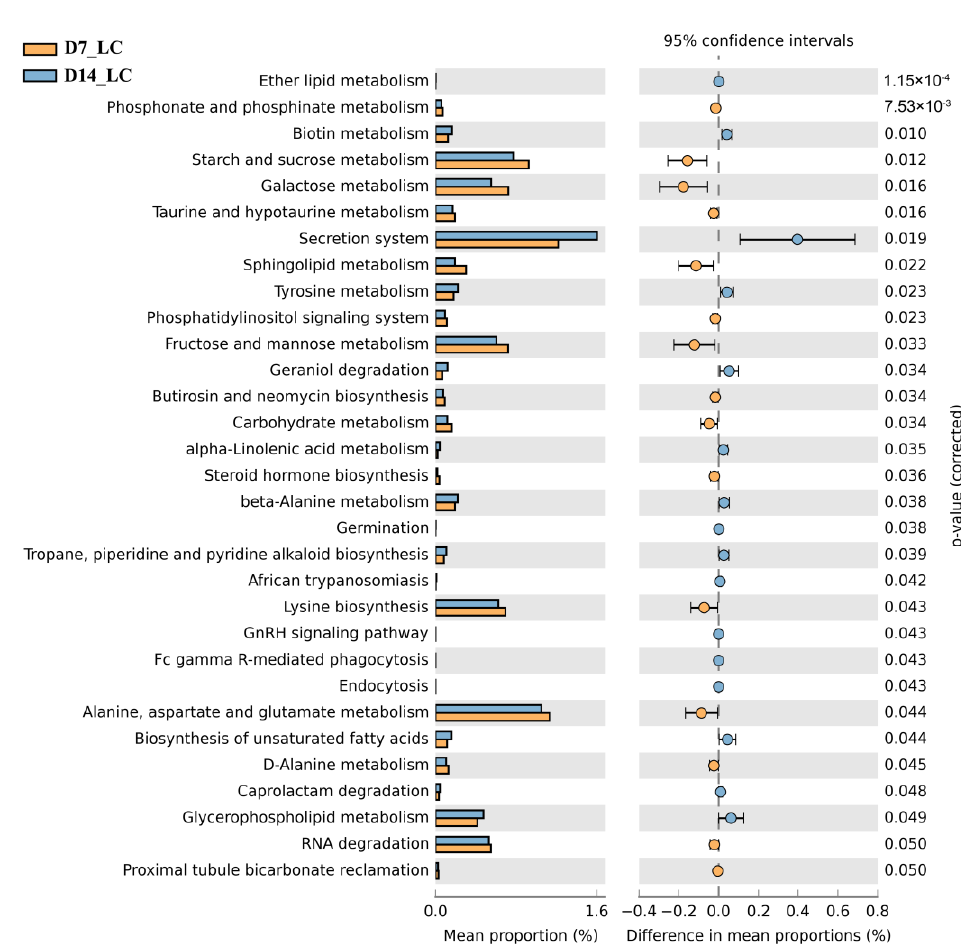
Figure 7. Intergroup variation of the intestinal microbes of E. sinensis in low concentration FF expo- sure. ( A ) Linear discriminant analysis effect size (LEfSe) of microbial abundance in LC group. ( B ) LDA score of LEfSe-PICRUSt from phylum to species level. Only the taxa with a linear discriminant analysis threshold score of 4.0 are shown.